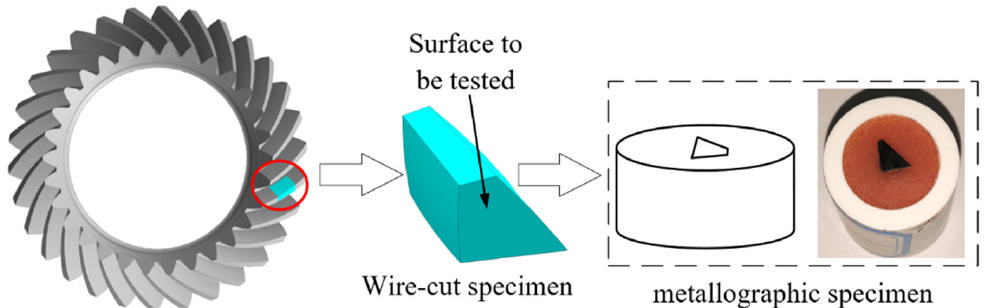
Figure 7. Schematic diagram of metallographic specimen production.